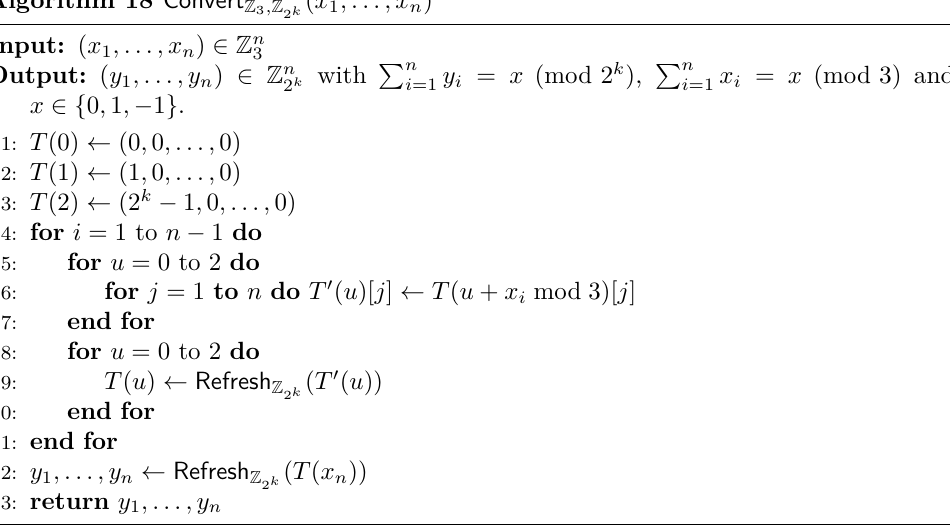
Algorithm 18 Convert Z